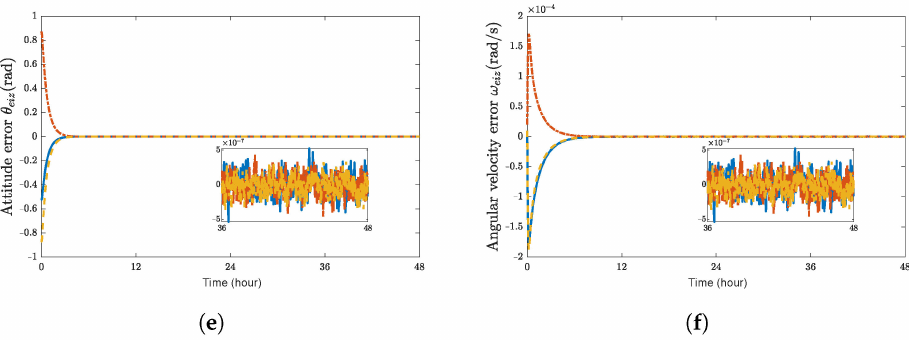
Figure 2. Attitude errors and angular velocity errors of spacecraft SC1 ∼ 3. ( a ) attitude error θ eix (rad); ( b ) angular velocity error ω eix (rad/s); ( c ) attitude error θ eiy (rad); ( d ) angular velocity error ω eiy (rad/s); ( e ) attitude error θ eiz (rad); ( f ) angular velocity error ω eiz (rad/s).